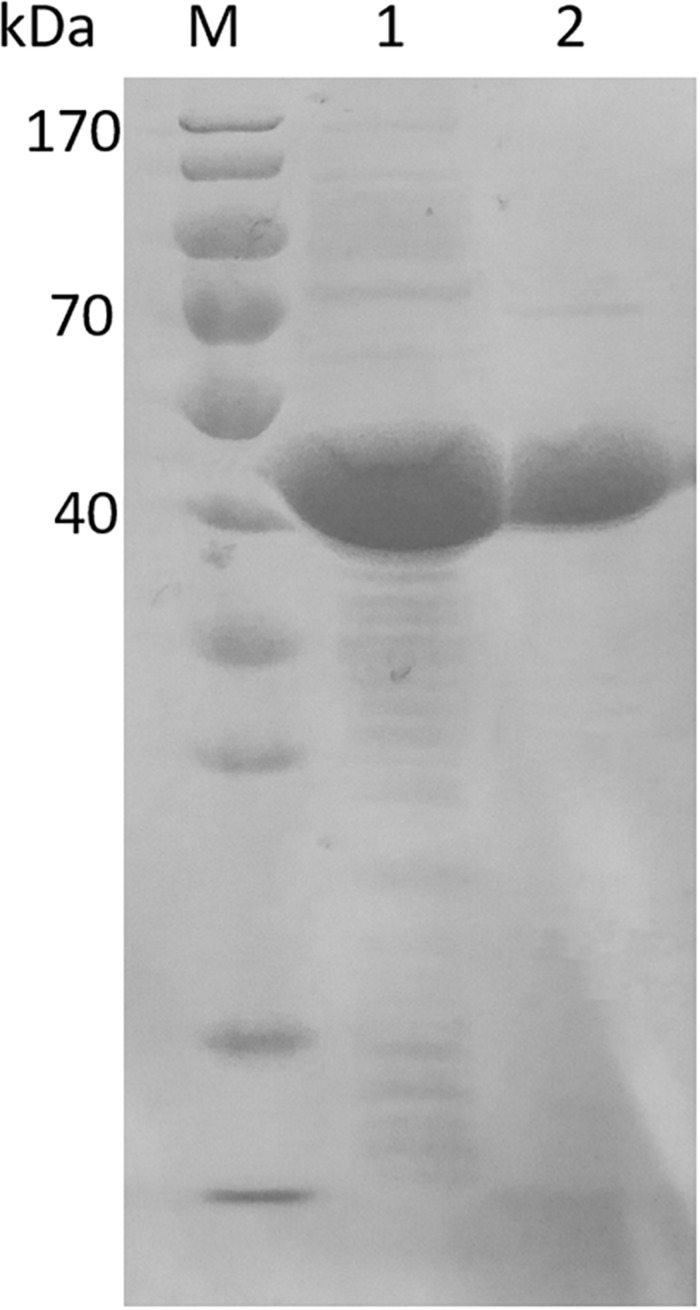
Electrophoresis of crude extract and purified EsiLeuDH. lane M, protein marker; lane 1, crude extract of EsiLeuDH; lane 2, purified EsiLeuDH.